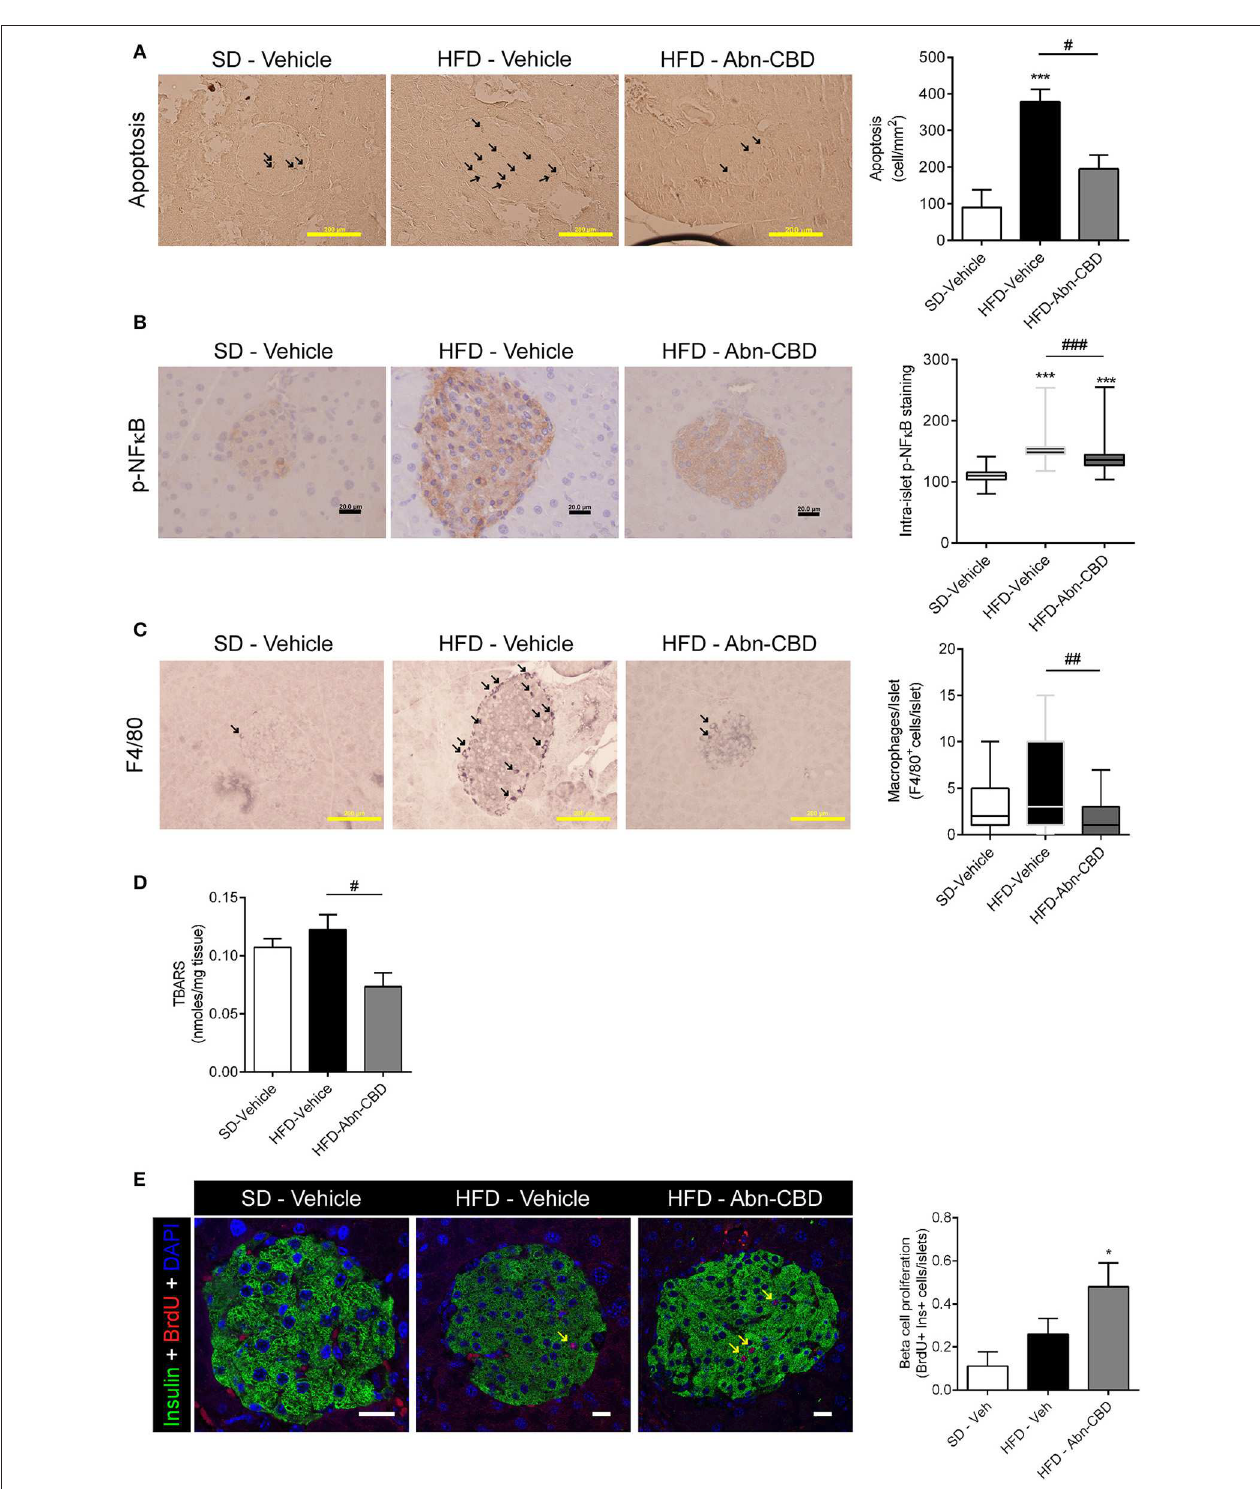
FIGURE 3 | Effect of Abn-CBD on pancreatic beta-cell viability and intra-islet inflammation. Representative photomicrographs and quantification of islets immunostained for apoptosis (A) and p-NF κ B (B) ; arrows indicate apoptotic cells; p-NF κ B immunostaining was counterstained with haematoxylin. (C) F4/80 staining; arrows indicate macrophages. (D) Quantification of lipid peroxidation by TBARS production. (E) Representative photomicrographs of double insulin (green) and BrdU (red) immunostaining in islets and quantification of BrdU + /Insulin + cells; arrows indicate proliferative beta cells; scale bar is 20 µ m. n = 6 SD-Vehicle, n = 7 HFD-Vehicle and n = 8 HFD-Abn-CBD. * p ≤ 0.05 and *** p ≤ 0.001 compared to SD-Vehicle; # p ≤ 0.05, ## p ≤ 0.01, and ### p ≤ 0.001 compared to HFD-Vehicle.